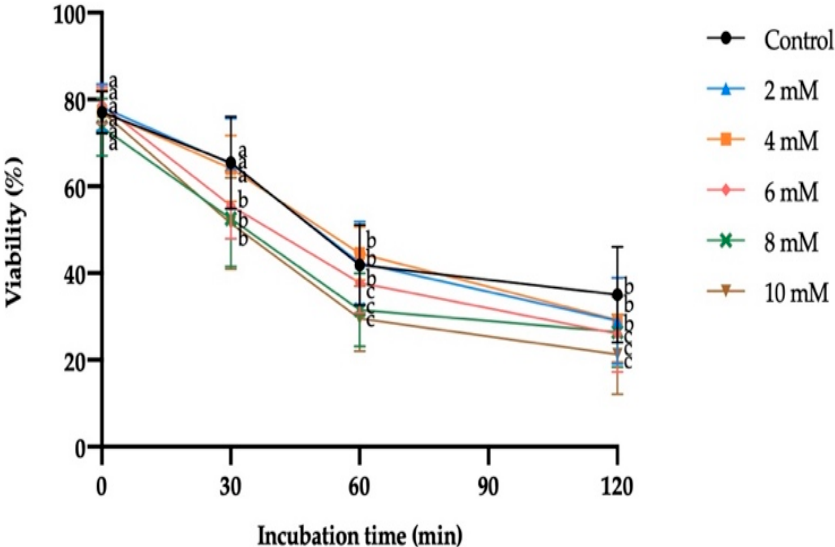
Figure 2. Mean ± SEM of viability of donkey sperm exposed to reductive stress with different reduced glutathione (GSH) concentrations measured at different incubation times. No significant differences were found between GSH concentrations within a given incubation time. (a–c) Different letters indicate significant differences ( p ≤ 0.05) between incubation times within a given GSH concentration.